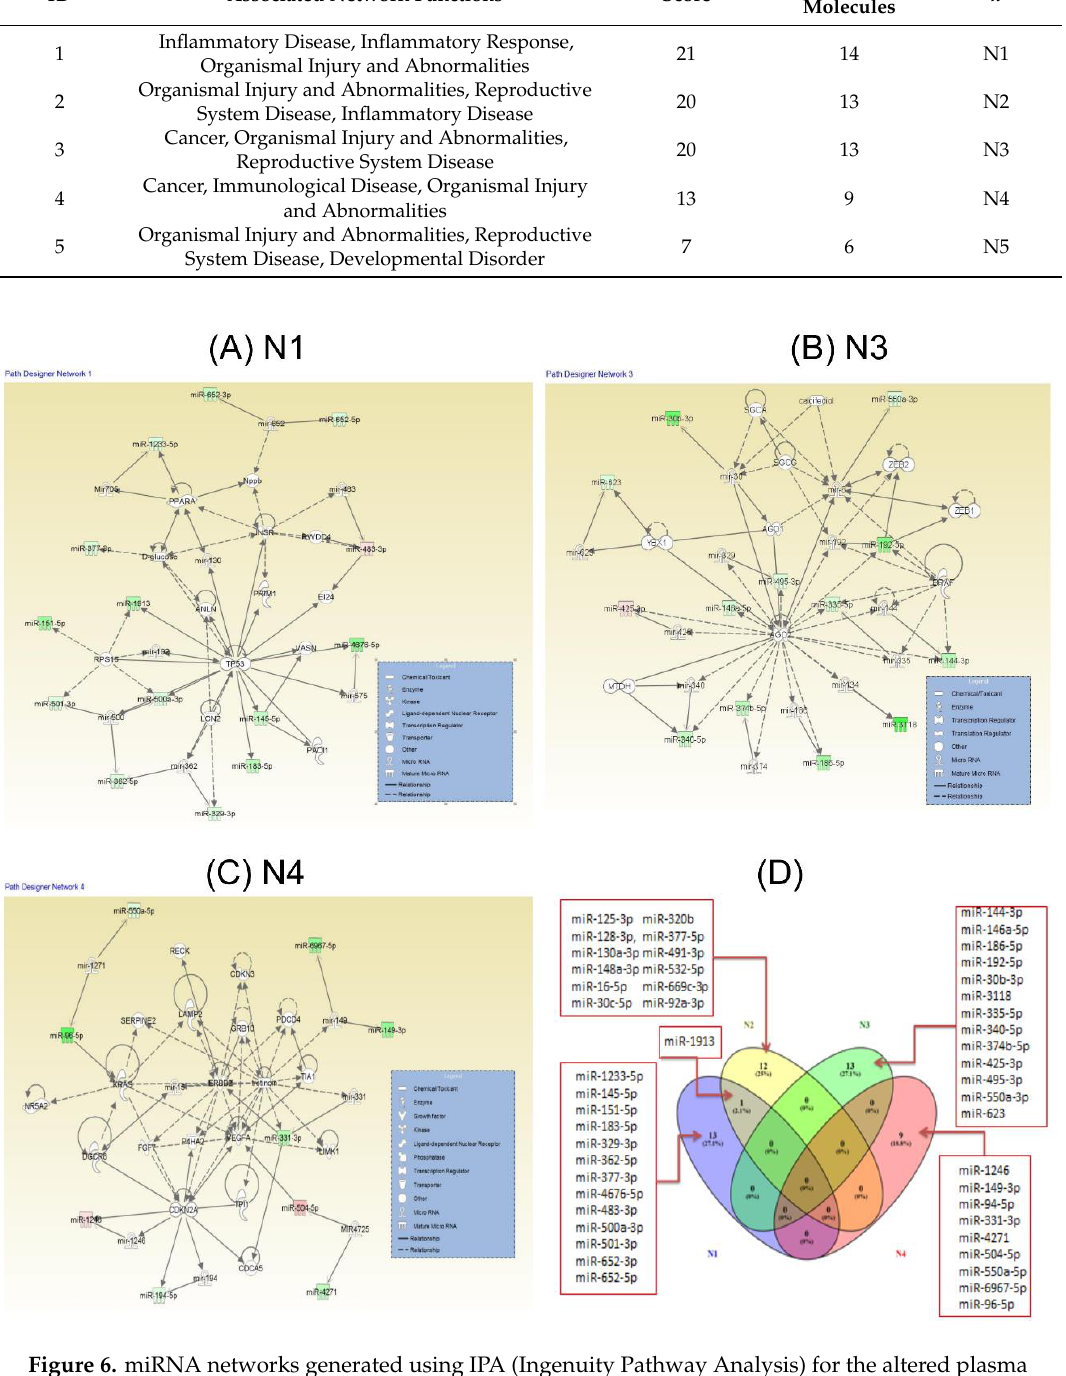
Figure 6. miRNA networks generated using IPA (Ingenuity Pathway Analysis) for the altered plasma miRNAs in colorectal cancer. ( A ) N 1: Inflammatory Disease, Inflammatory Response, Organismal Injury and Abnormalities. ( B ) N 3: Cancer, Organismal Injury and Abnormalities, Reproductive System Disease. ( C ) N 4: Cancer, Immunological Disease, Organismal Injury and Abnormalities. ( D ) Venn diagram for miRNA altered networks.